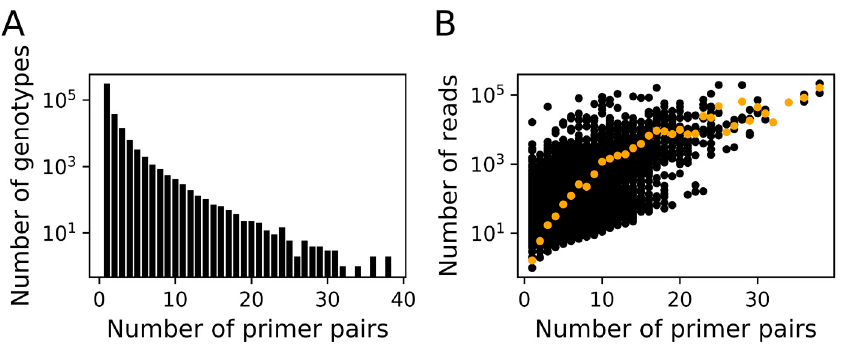
Figure 3. Genotypes represented by Megaviridae polB meta-barcodes. ( A ) Number of identified genotypes are plotted against the number of primer pairs that amplified individual genotypes. ( B ) Number of reads that support individual genotypes are plotted against the number of primer pairs that amplified corresponding genotypes. Average number of reads for each group of genotypes are shown by an orange dot.